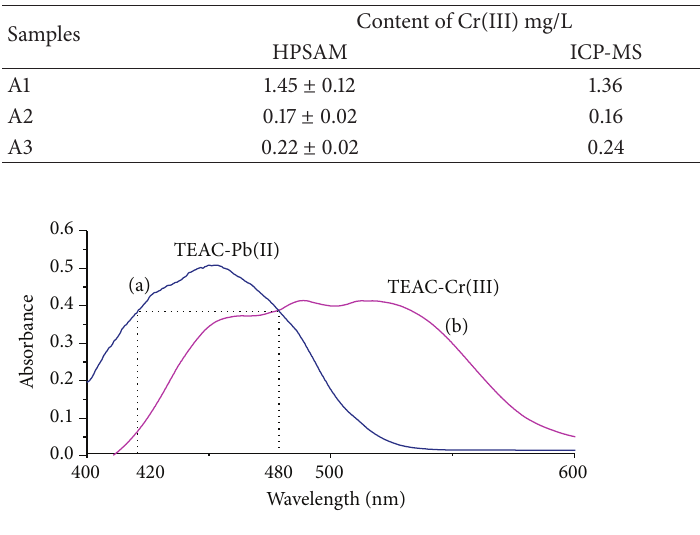
Figure 10: Selected wavelengths for HPSAM method at pH 10.5 (a), TEAC-Pb(II), and (b) TEAC-Pb(II).